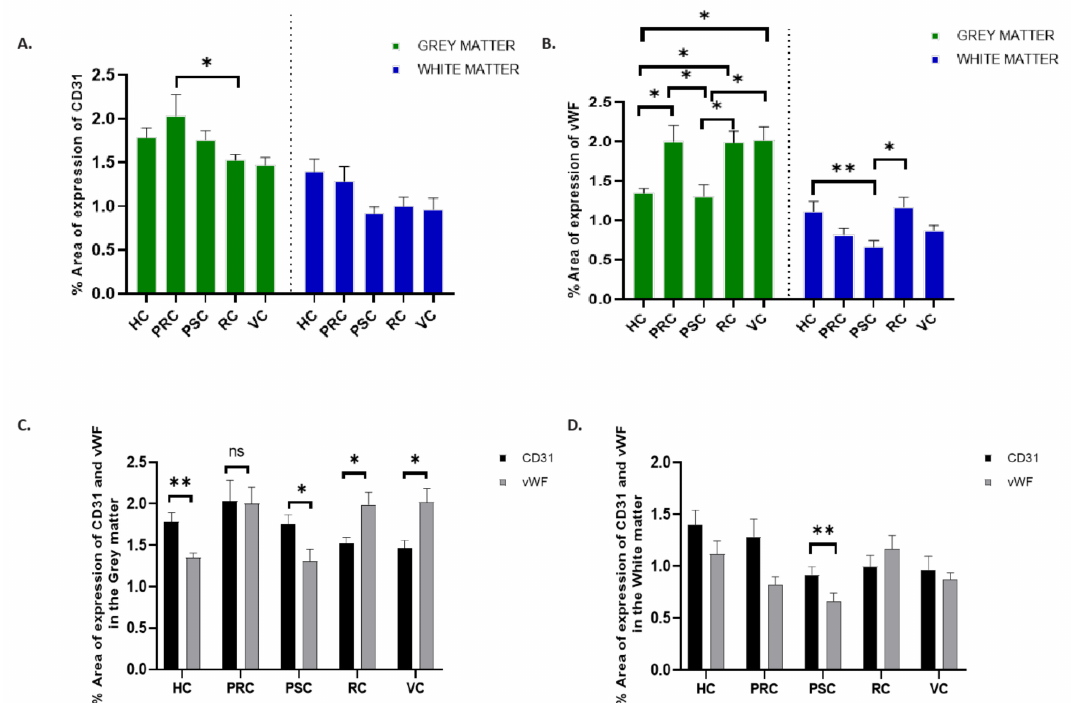
Figure 2. Quantification of the percentage area of expression of CD 31 and vWF. There was a significant di ff erence in the expression of CD31 only in the grey matter between precentral gyrus and rhinal cortex ( A ). Significant di ff erences were observed more in vWF expression in the grey matter of all the regions ( B ). Stronger di ff erences in the expression of vWF in the white matter occurred between the hippocampus and the postcentral gyrus. On comparing the expression of both biomarkers, there was equal expression of both biomarkers in the grey matter of the precentral gyrus ( C ) while the expression of vWF was dominant in the visual and the rhinal cortex. In the white matter ( D ), vWF expression was higher in the rhinal cortex only and there was a statistically significant di ff erence between both biomarkers in the postcentral gyrus. HC = hippocampus. PRC = Precentral cortex. PSC = Post central cortex. RC = rhinal cortex. VC = visual cortex. Error bars represent mean ± SEM. * p ≤ 0.05. ** p ≤ 0.001. (n = 15; 3 patients, 5 regions of